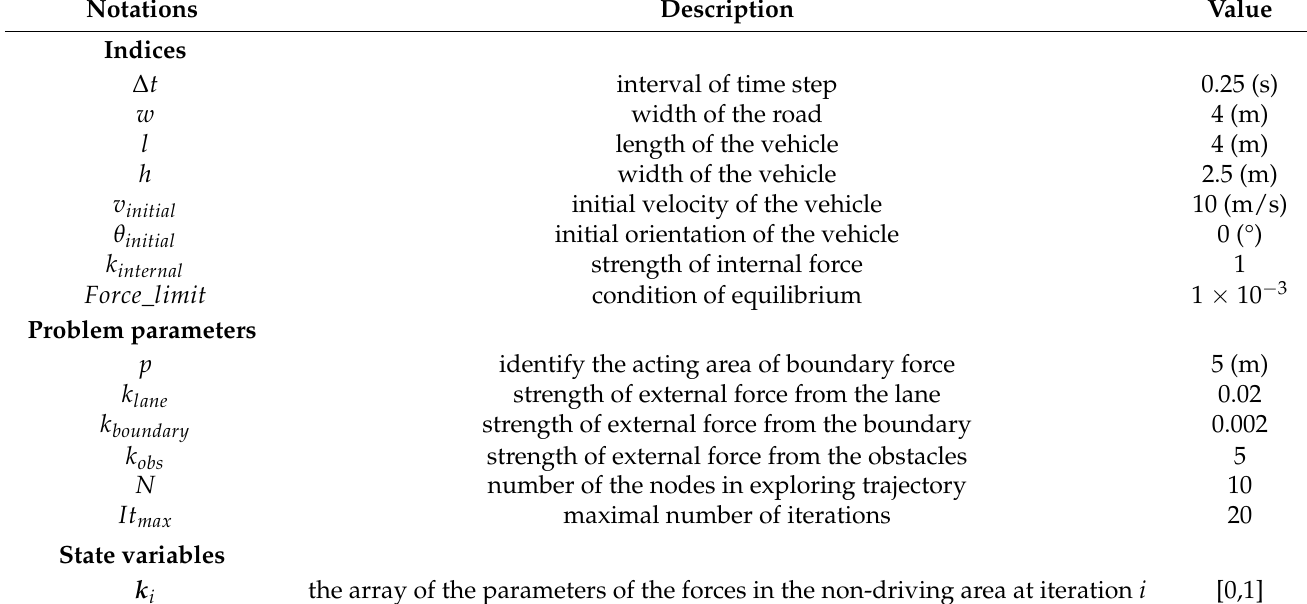
Table 1. Parameters adopted in the simulations.